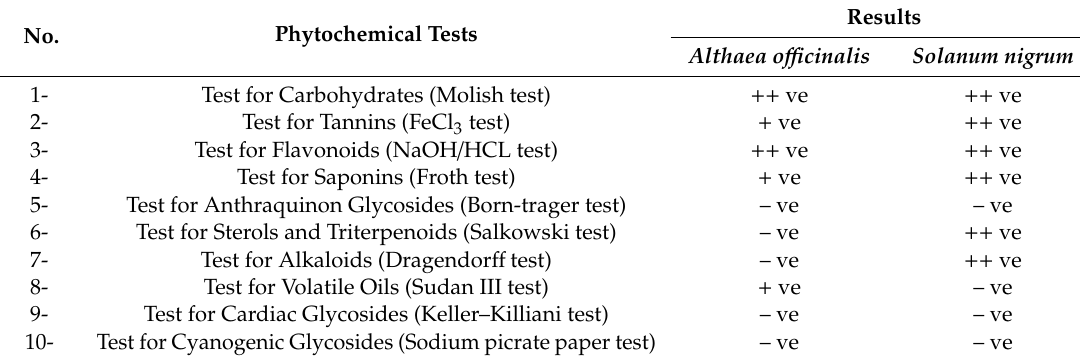
Figure 1. Pictures showing results of preliminary phytochemical screening of ( a ) Althaea officinalis flower extract in hot water, and ( b ) Solanum nigrum fruit extract in 99% ethanol. Where: ( a1 , b1 ): for carbohydrates, ( a2 , b2 ): for tannins, ( a3 , b3 ): for flavonoids, ( a4 , b4 ): for saponins, ( a5 , b5 ): for anthraquinone glycosides, ( a6 , b6 ): for sterols and triterpenoids, and ( a7 , b7 ): for alkaloids. Table 1. Preliminary phytochemical screening of Althaea officinalis flower extract in hot water and Solanum nigrum fruit extract in 99% ethanol.